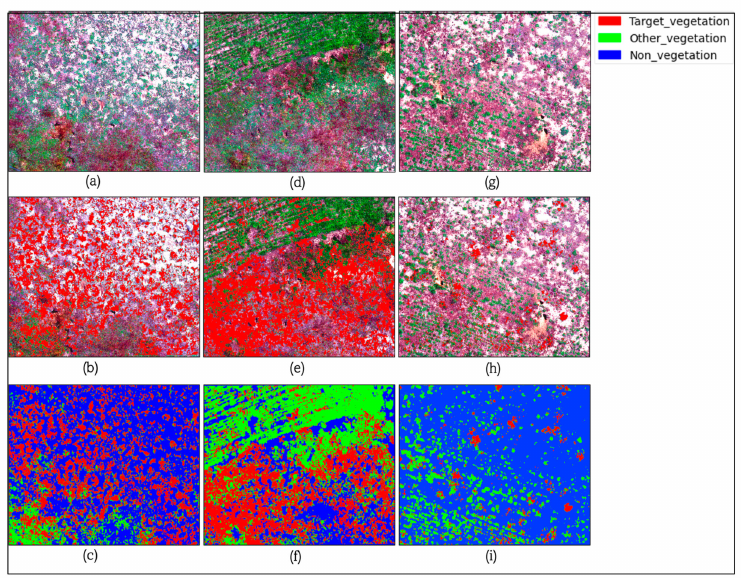
Figure 16. Prediction results at different region of interest (EPSG:4326—WGS 84) ( a , d , g )—Different region of study sites; ( b , e , h )—Prediction result of hawkweed foliage; ( c , f , i )—Prediction results of all classes (Hawkweed foliage, other vegetation, and